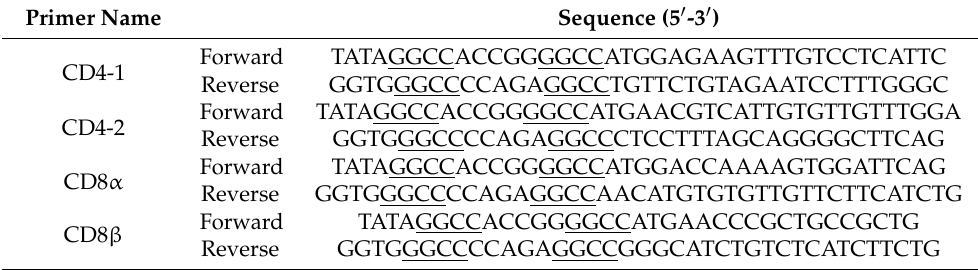
Table 3. Oligonucleotide sequence of whole DNA fragments for plasmid